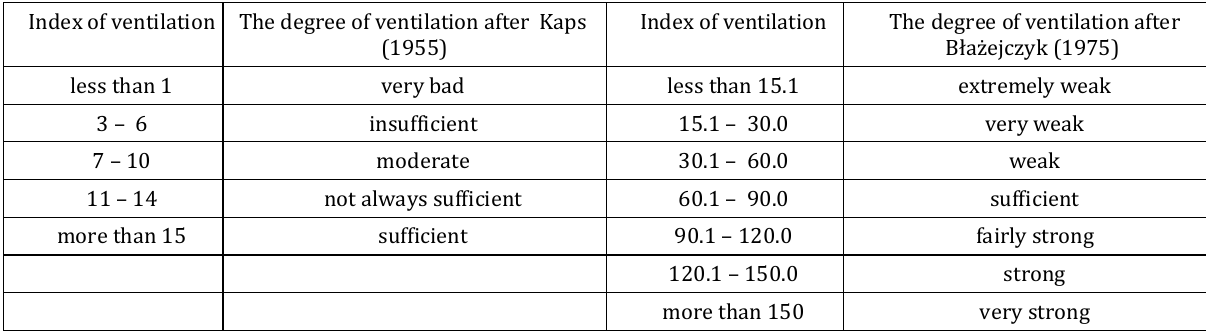
Table 1. The degree of ventilation of valleys after Kaps (1955) and Błażejczyk (1975) Index of ventilation The degree of ventilation after Kaps Index of ventilation The degree of ventilation (1955)